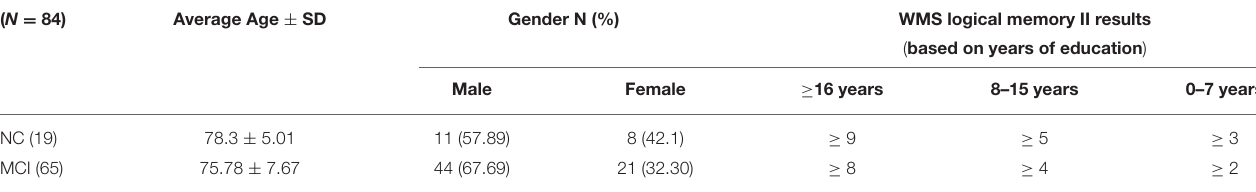
TABLE 1 | The demographic data of the NC and MCI groups of the 11 C PiB-PET